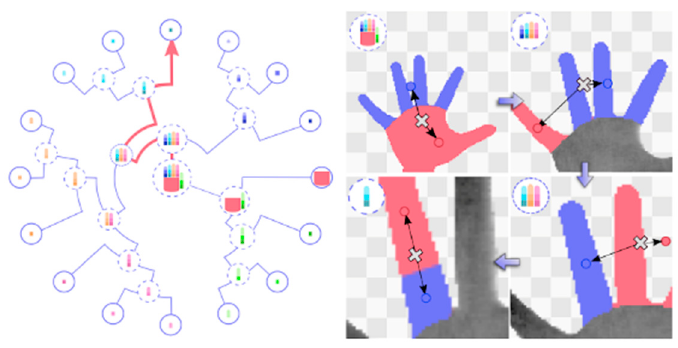
Figure 9. A binary latent tree model (LTM)-based [75] search process for skeletal joint position